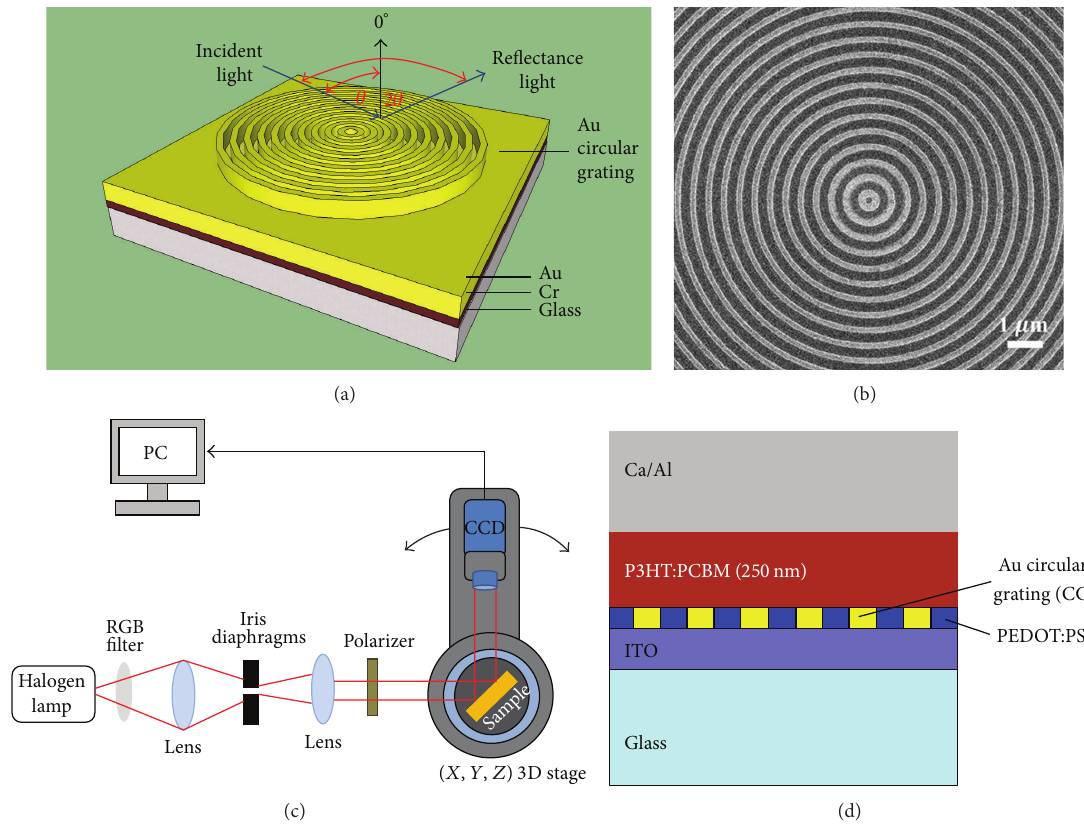
Figure1:(a)Schematicrepresentationofasampleforaglasssubstrate/Crfilm(2 nm)/Aufilm(47 nm)/Auconcentriccirculargrating(50 nm). (b) An SEM image of the fabricated PCN sample. The grating ring width and pitch size of the pattern are 250 nm and 500nm, respectively. (c) The optical setup for reflected intensity measurement. (d) Cross-sectional view of the thin-film OSCs architecture made of glass/ITO/Au circular grating/PEDOT:PSS/P3HT:PCBM/Ca/Al. A 50 nm-thick PCN was fabricated on the ITO anode layer using standard electron beam lithography and lift-off